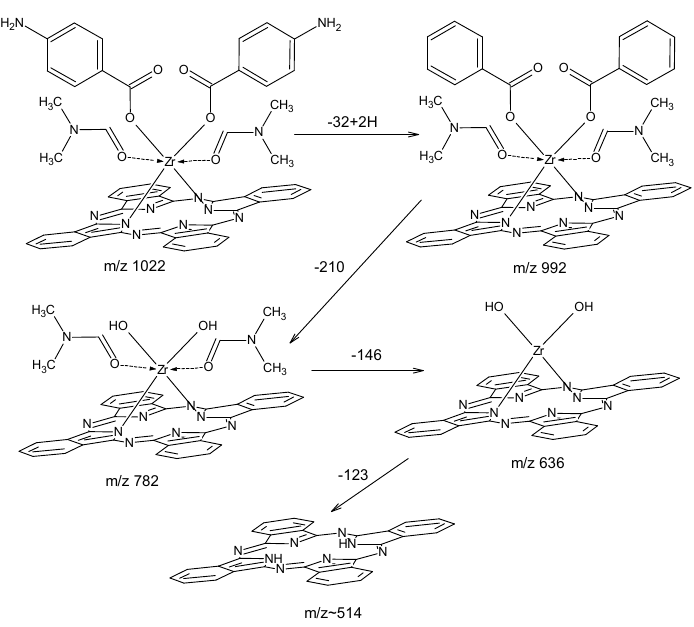
Figure 3. Fragmentation pattern of phthalocyanine complexes according to ESI-MS analysis.